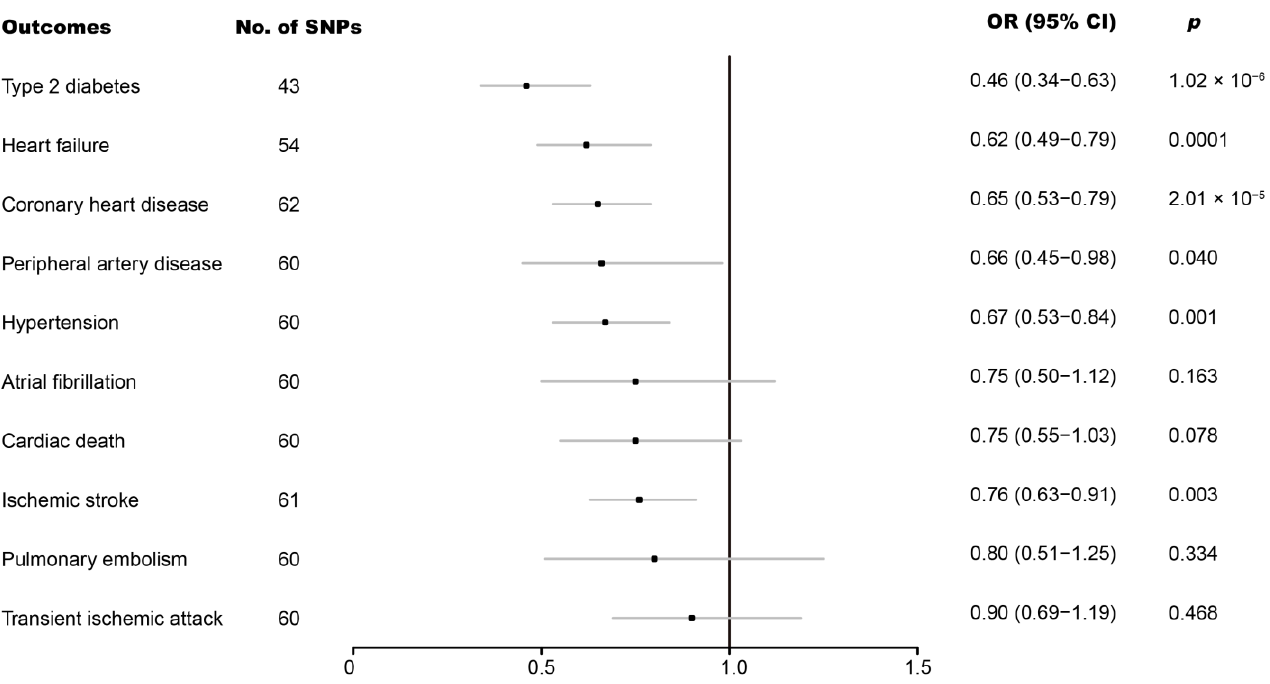
Figure 2. Associations of genetically predicted cheese intake with cardiovascular diseases. CI, confidence interval; OR, odds ratio; SNP, single-nucleotide polymorphism.